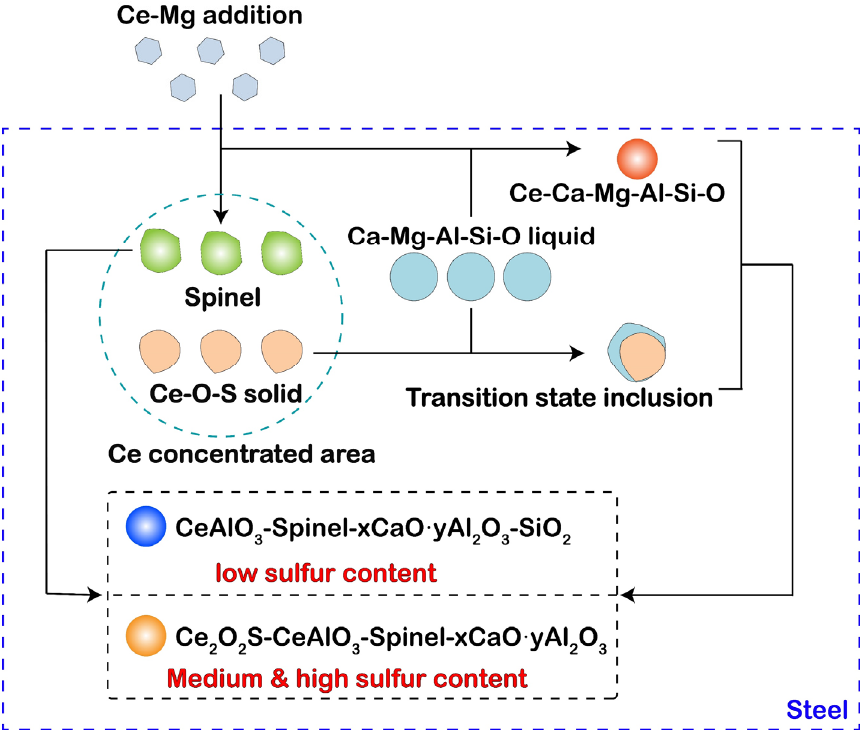
Figure 10. Schematic diagram of inclusion evolution after Ce-Mg addition.